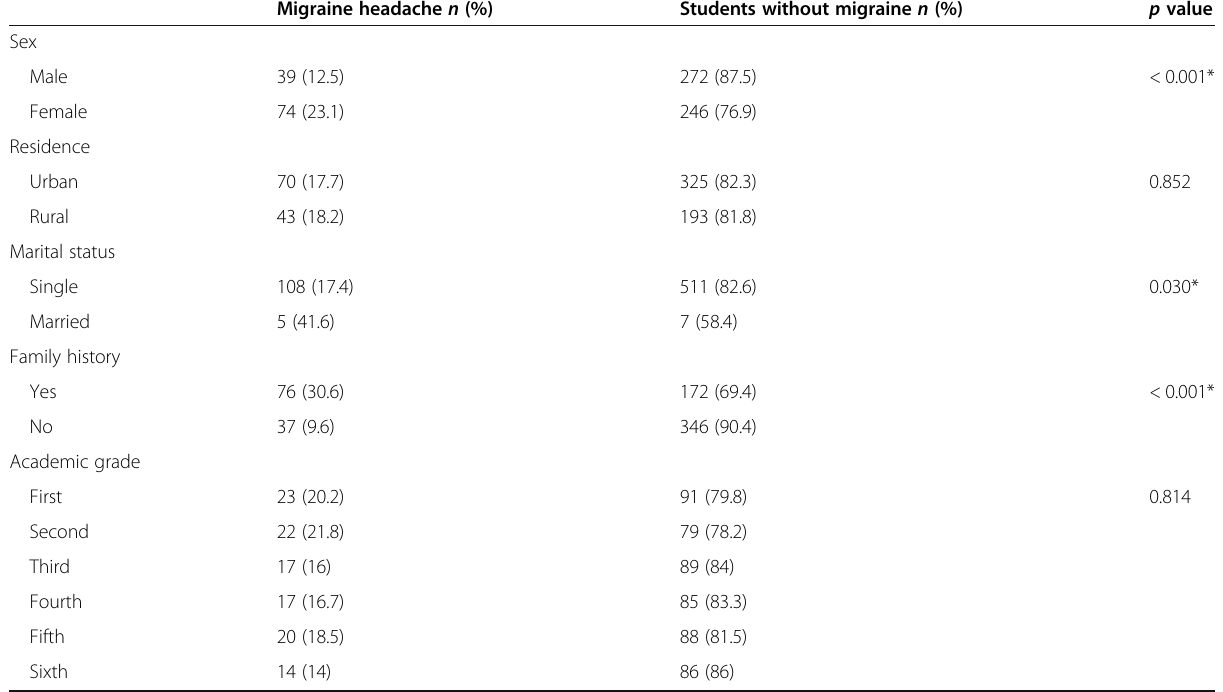
Table 4 Socio-demographic characteristics of medical students with migraine